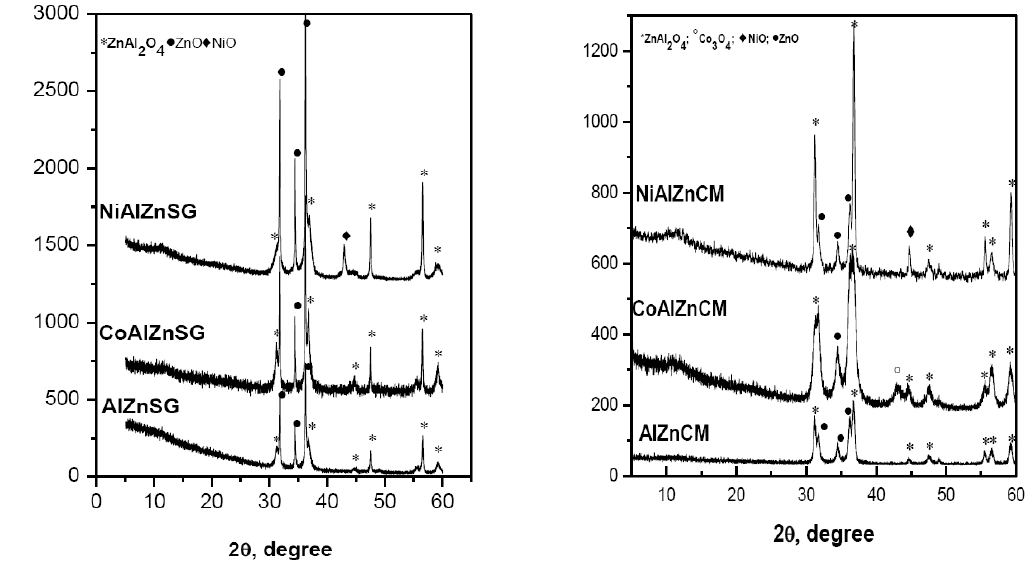
Figure 2. X-ray diffractions of the samples prepared by the sol-gel method (left), and by the citrate method